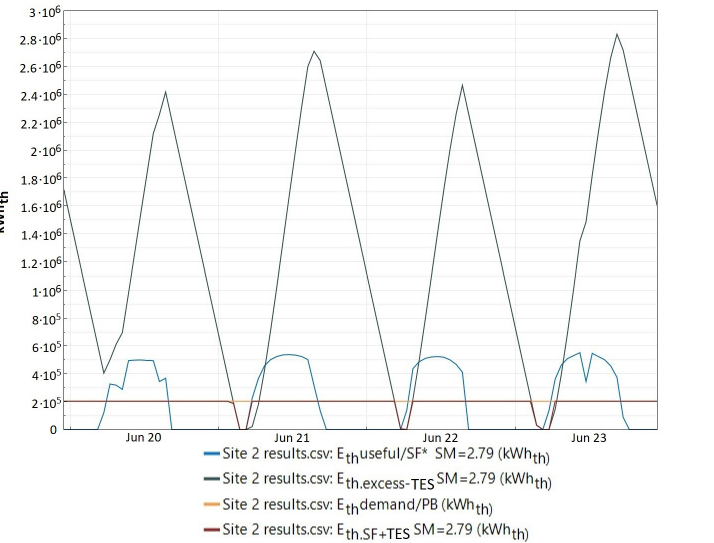
Figure 5. Evolution of the main simulated thermal variables around the design day through the proposed mathematical model—site 2